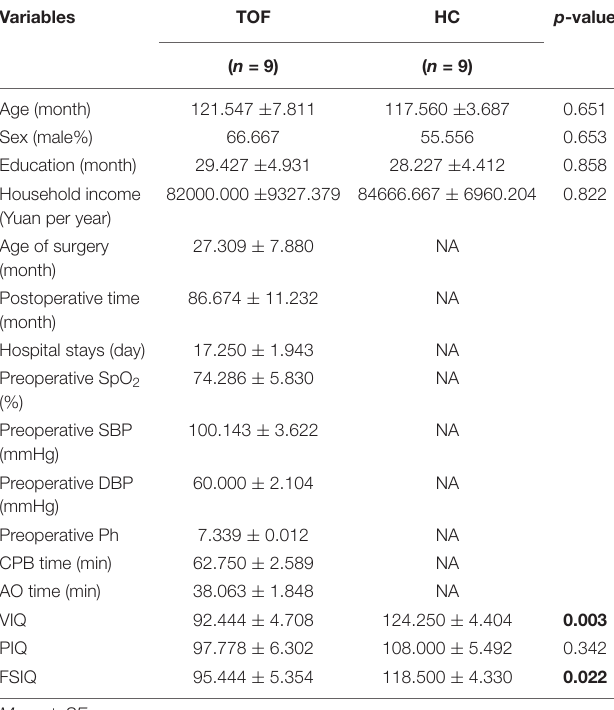
TABLE 3 | Cerebral ALFF changings in TOF